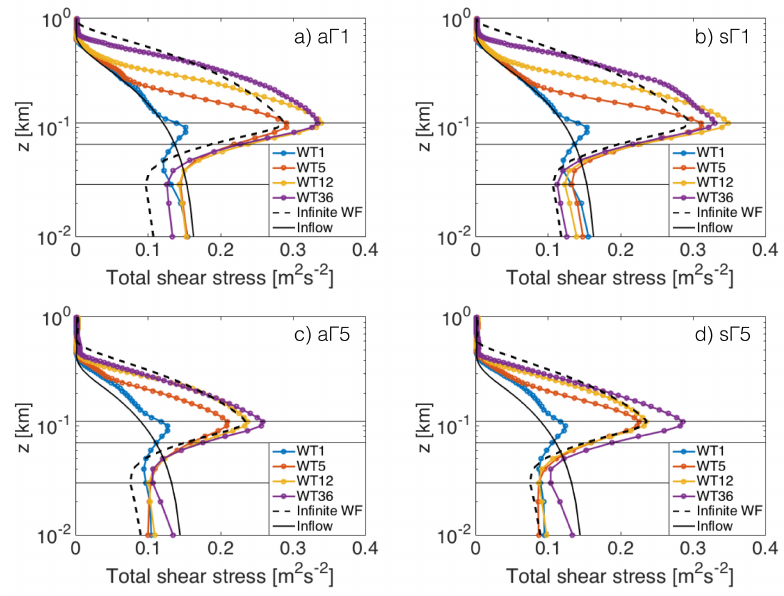
Figure 9. Vertical profiles of time- and spanwise-averaged total shear stress at the 1st, 5th, 12th and 36th turbine rows for the cases: ( a ) FS-a Γ 1; ( b ) FS-s Γ 1; ( c ) FS-a Γ 5; and ( d ) FS-s Γ 5. The black solid profile represents the total shear stress of the ABL inflow, and the black dashed profile represents the time- and horizontal-averaged total shear stress of the infinite wind farm with the same wind farm configuration. The black horizontal solid lines represents the top-tip, hub and bottom-tip